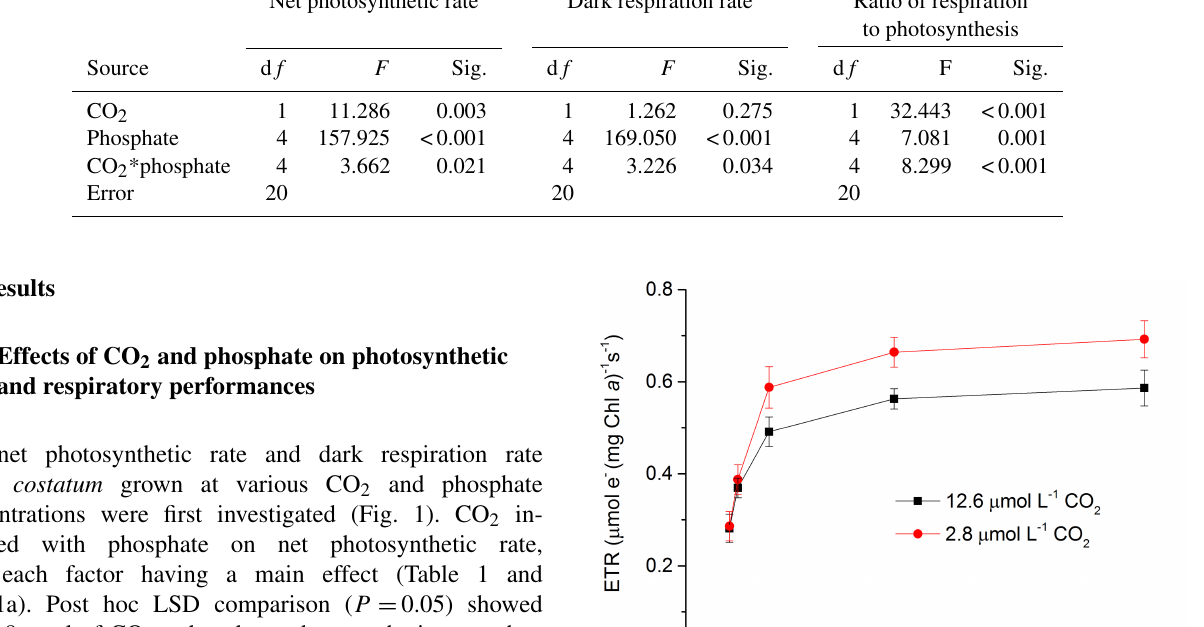
Table 1. Two-way analysis of variance for the effects of CO 2 and phosphate on net photosynthetic rate, dark respiration rate, and ratio of respiration to photosynthesis of S. costatum . CO 2 *phosphate means the interactive effect of CO 2 and phosphate, d f means degree of freedom, F means the value of the F statistic, and Sig. means the p value. Net photosynthetic rate Dark respiration rate Ratio of respiration to photosynthesis Source